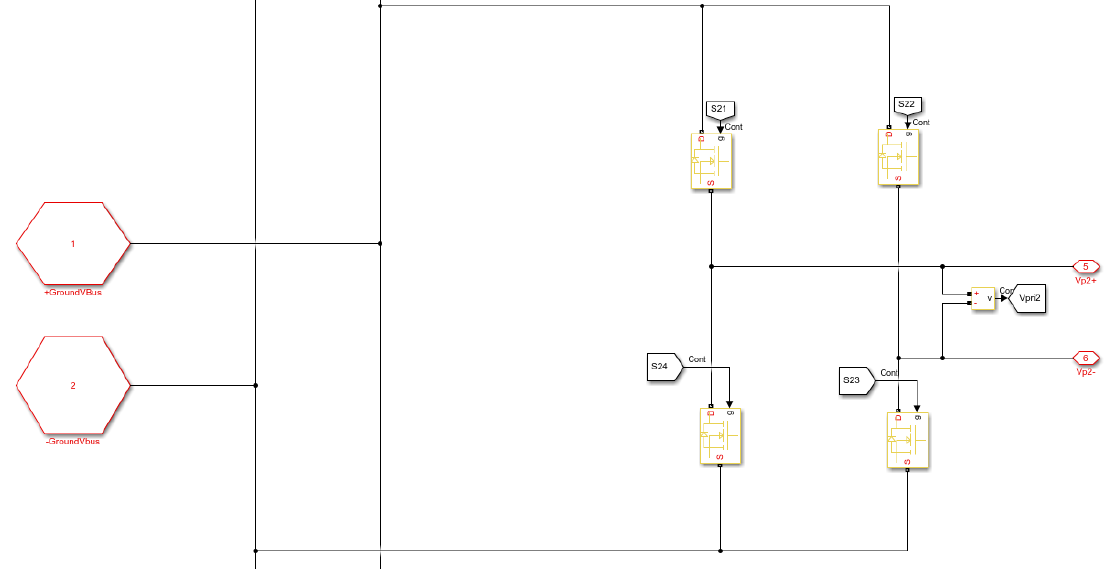
Figure A1. H- bridge inverter (four are used inside the “Ground Side Module” block).